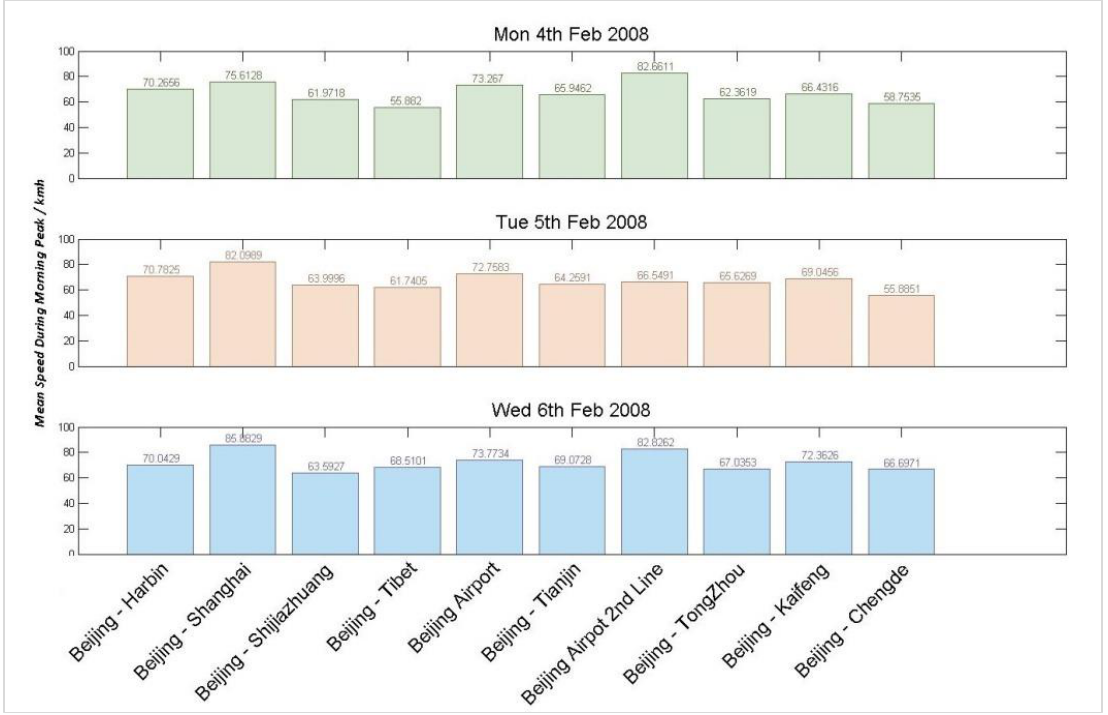
Figure 7. Average estimated link speed on 10 expressways in Beijing for the three days of